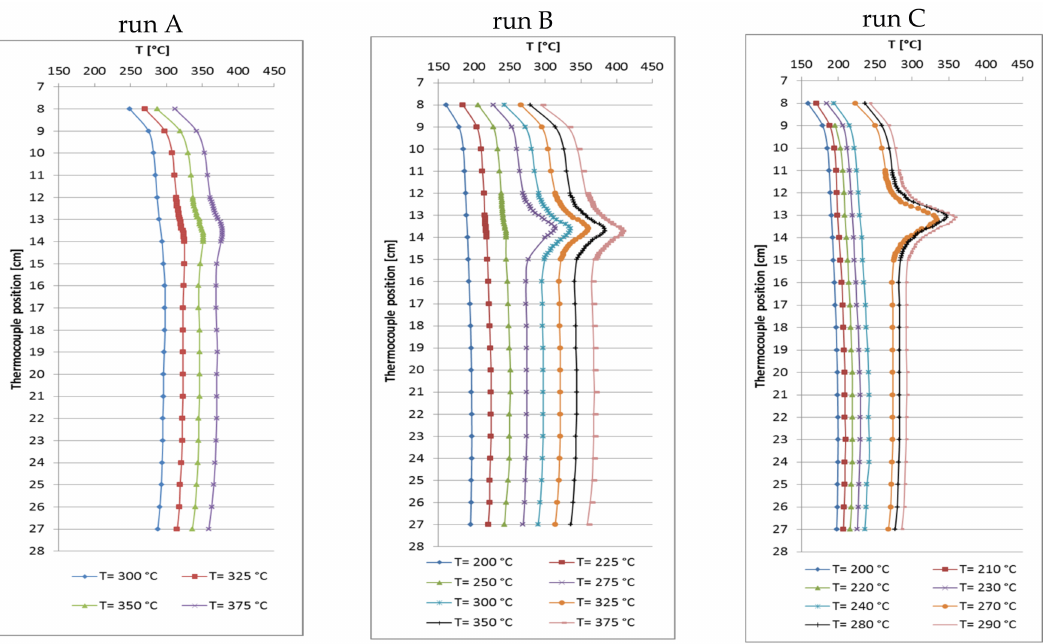
Figure 2. Recorded temperature profiles for methanation on 18Ni/Al 2 O 3 . Run A: 1 mL catalyst + 4 mL quartz; run B: 2.5 mL catalyst + 2.5 mL quartz; run C: 4 mL catalyst + 1 mL quartz (GHSV ∼ = 6000 h − 1 ; CO 2 :H 2 :N 2 = 1.8:7.2:1; 10